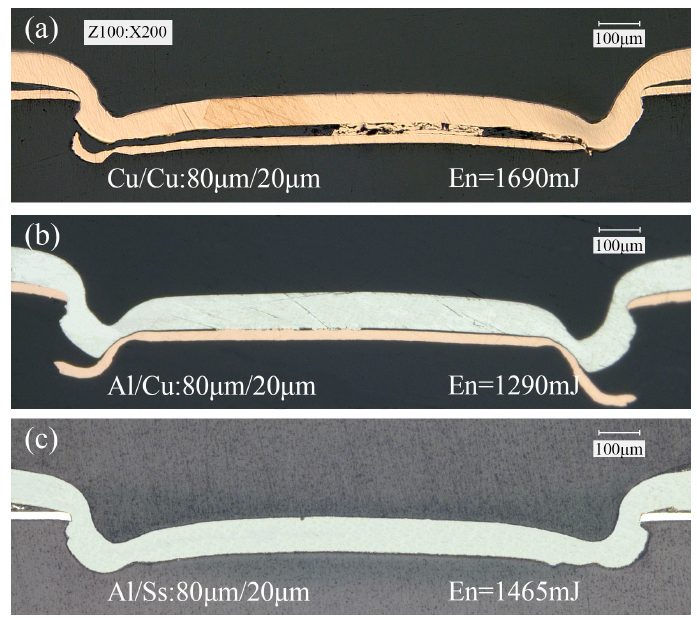
Figure 11. Cross sections of clinched joints with different material combinations. ( a ) Cu/Cu; ( b ) Al/Cu; and ( c ) Al/Ss. Materials 2016 , 9 , 571 11 of 15